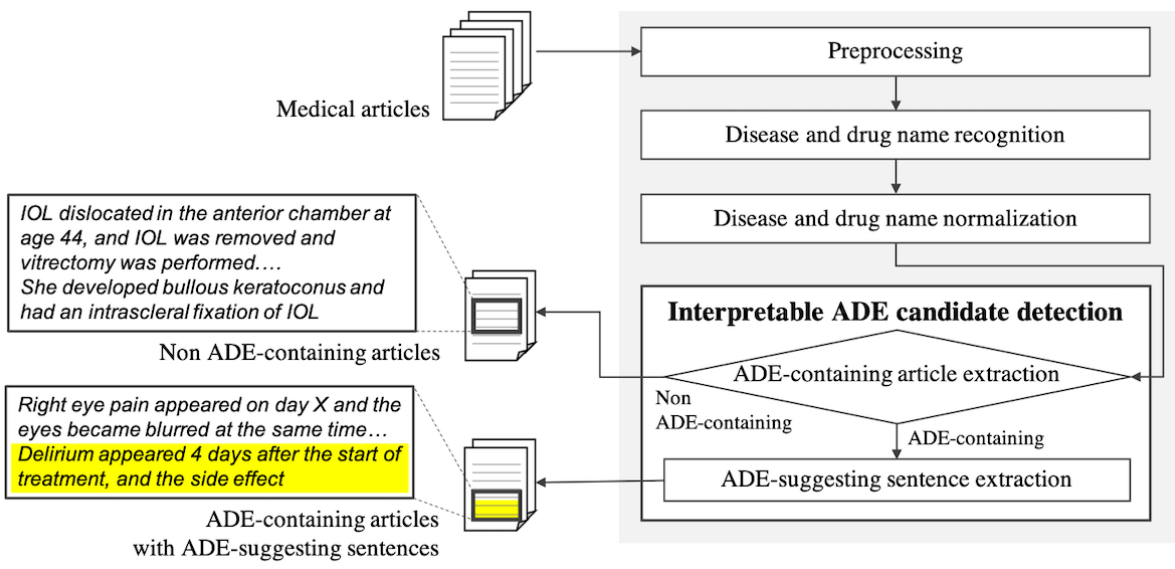
Table 1. Average number of sentences and characters per medical article. ADE a suggesting, mean (SD)